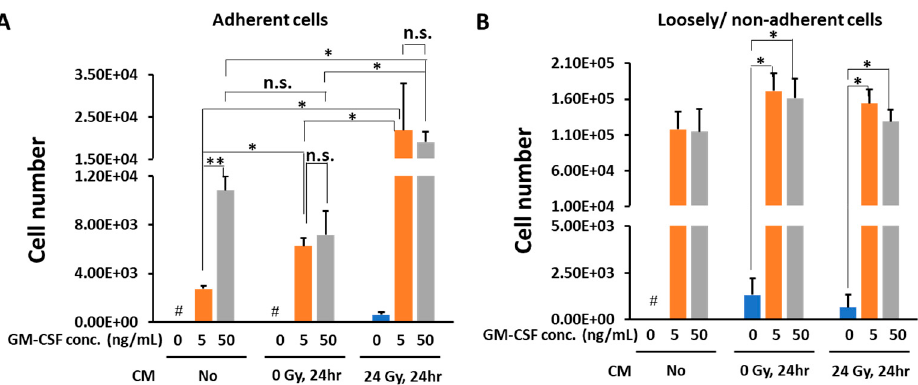
Figure 2. Cell number changes of bone marrow cells on day 6 after culture with GM-CSF and CM from non-irradiated or 24 h after 24 Gy γ -irradiated B16 cells. The cell number counted results of the adherent cells ( A ) and loosely/non-adherent cells ( B ). Mean ± SE, n = 3. *, P < 0.05. **, P < 0.005. #, no living cells.